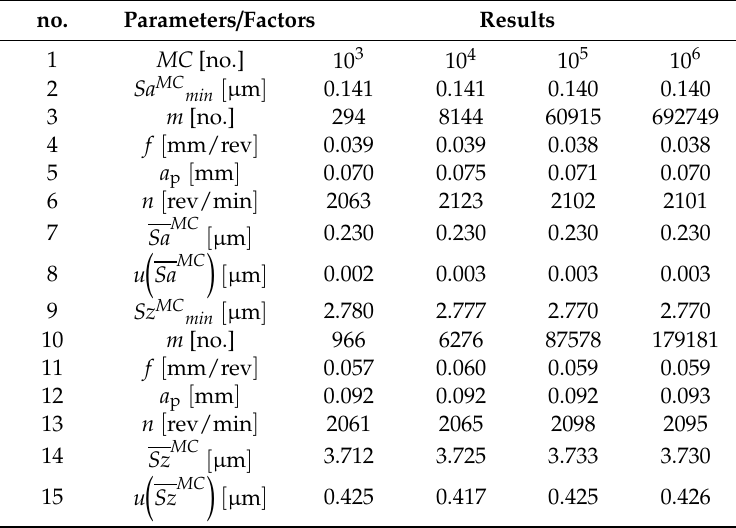
Table 5. Calculation results of the minimum value of Equations (3) and (4) by using the MC method. no. Parameters / Factors Results 1 MC